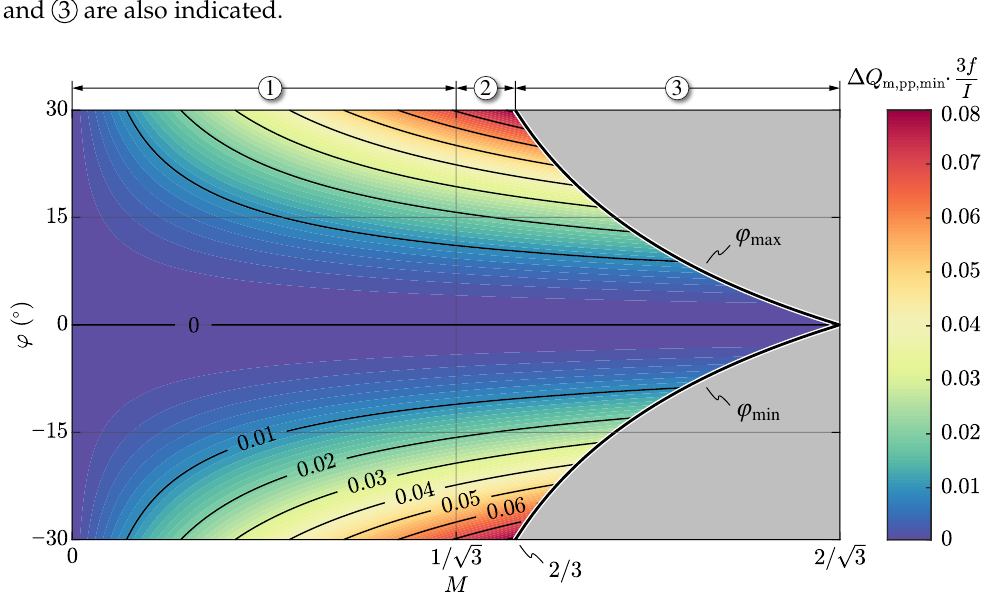
Figure A5. Minimum DC-link mid-point charge ripple ∆ Q m,pp (i.e., normalized with respect to the peak phase current I and three-times the grid frequency 3 f ) as a function of the modulation index M and the converter-side power factor angle ϕ . The three modulation index regions 1 , 2 and 3 are